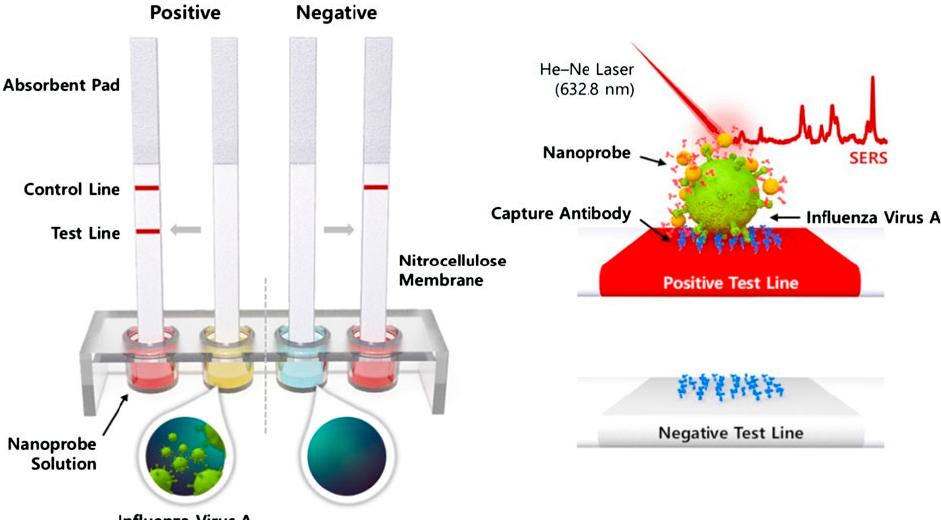
Figure 11. Schematic representation of the SERS-based LFA. ( a ) When the A(H1N1) was present in the sample solution, the SERS-virus complexes were formed and captured by the test line anti-bodies; excess SERS nanoprobes continued to flow and were captured by antibodies in the control line. In this scenario, the buildup of AuNPs causes both the control and test lines to turn red ( left , positive). If the fluid contains no viruses, just the control line goes reddish (negative, right ). ( b ) The associated SERS-virus nanoprobe complexes produced a SERS spectrum ( top ), but no signal was produced in the absence of the virus ( bottom ). Reproduced with permission from ref. [95]. Copyright 2016 John Wiley & Sons, Inc.